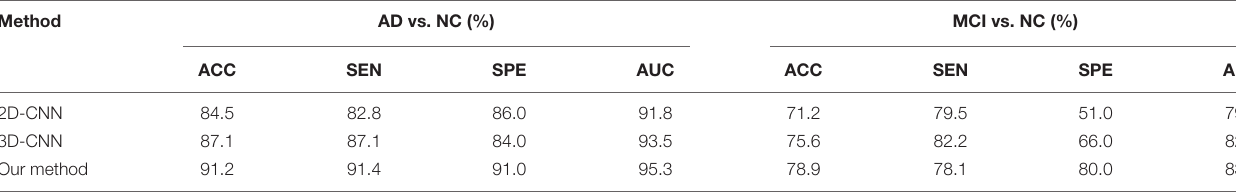
TABLE 4 | Comparison of the classification performances with 2D/3D CNNs and the proposed method.